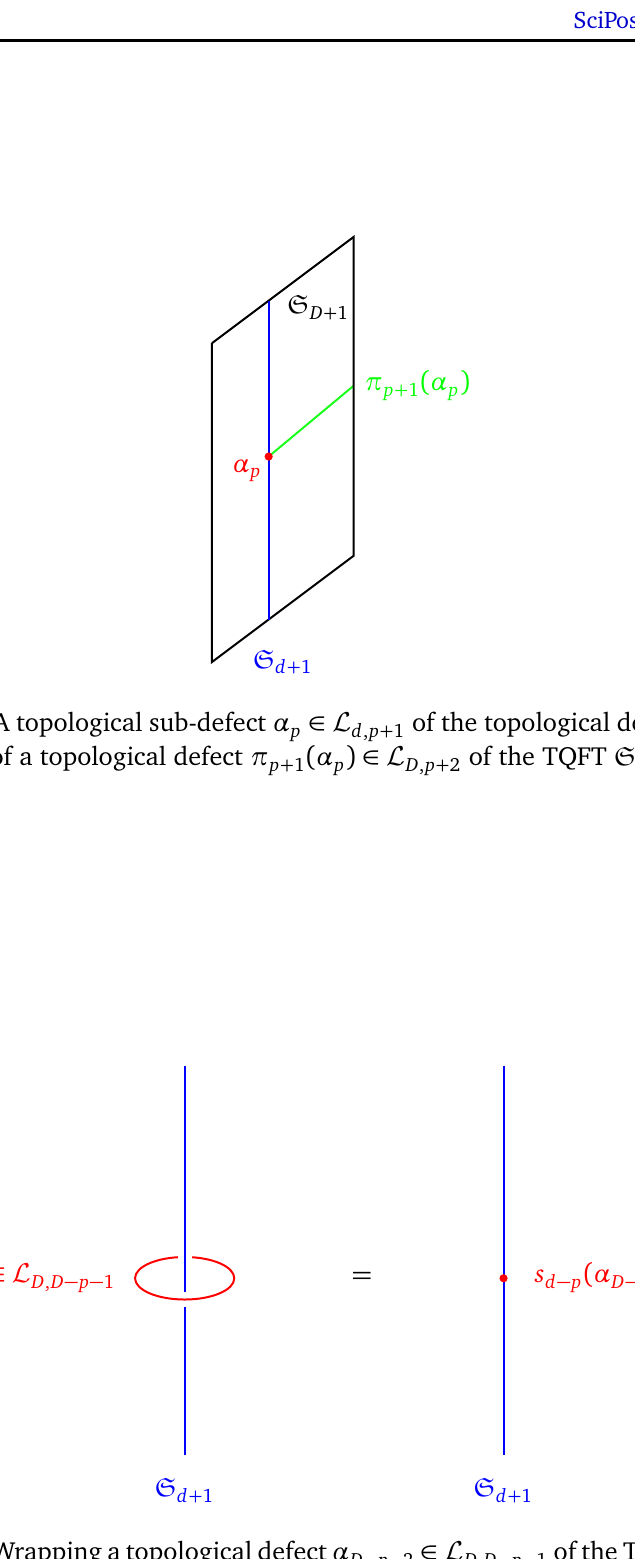
Figure 12: Wrapping a topological defect α a sphere S D − d − 1 surrounding the topological defect S to a sub-defect s defect is not attached to any other topological defect, it is actually valued in L 0